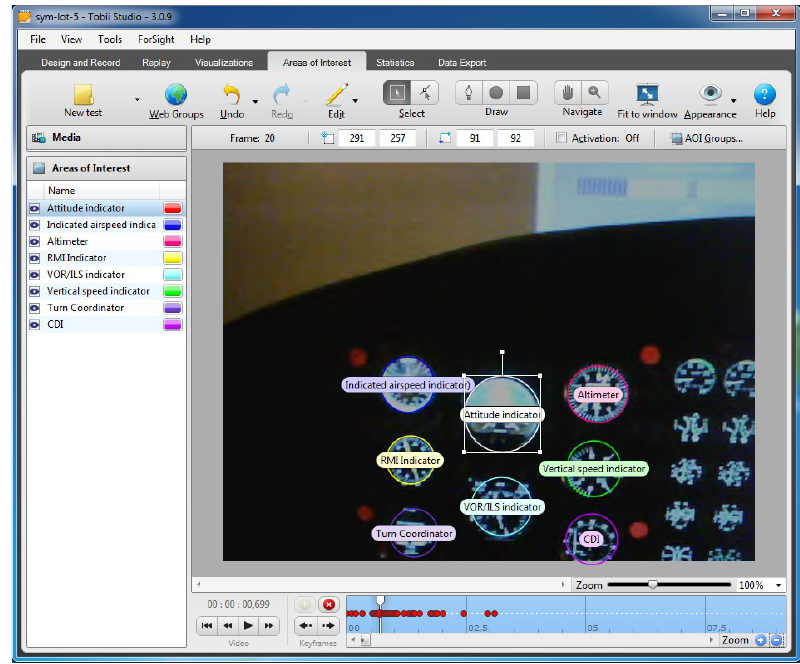
Figure 6. Tobii Pro Studio software used in order to define AOI corresponding to the positions of cockpit